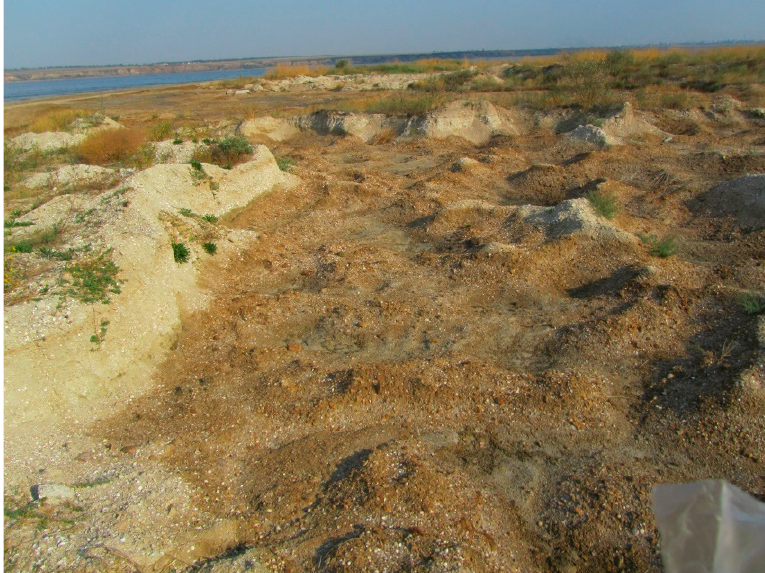
Figure 11. The sand quarry site (surroundings of Illinka village).